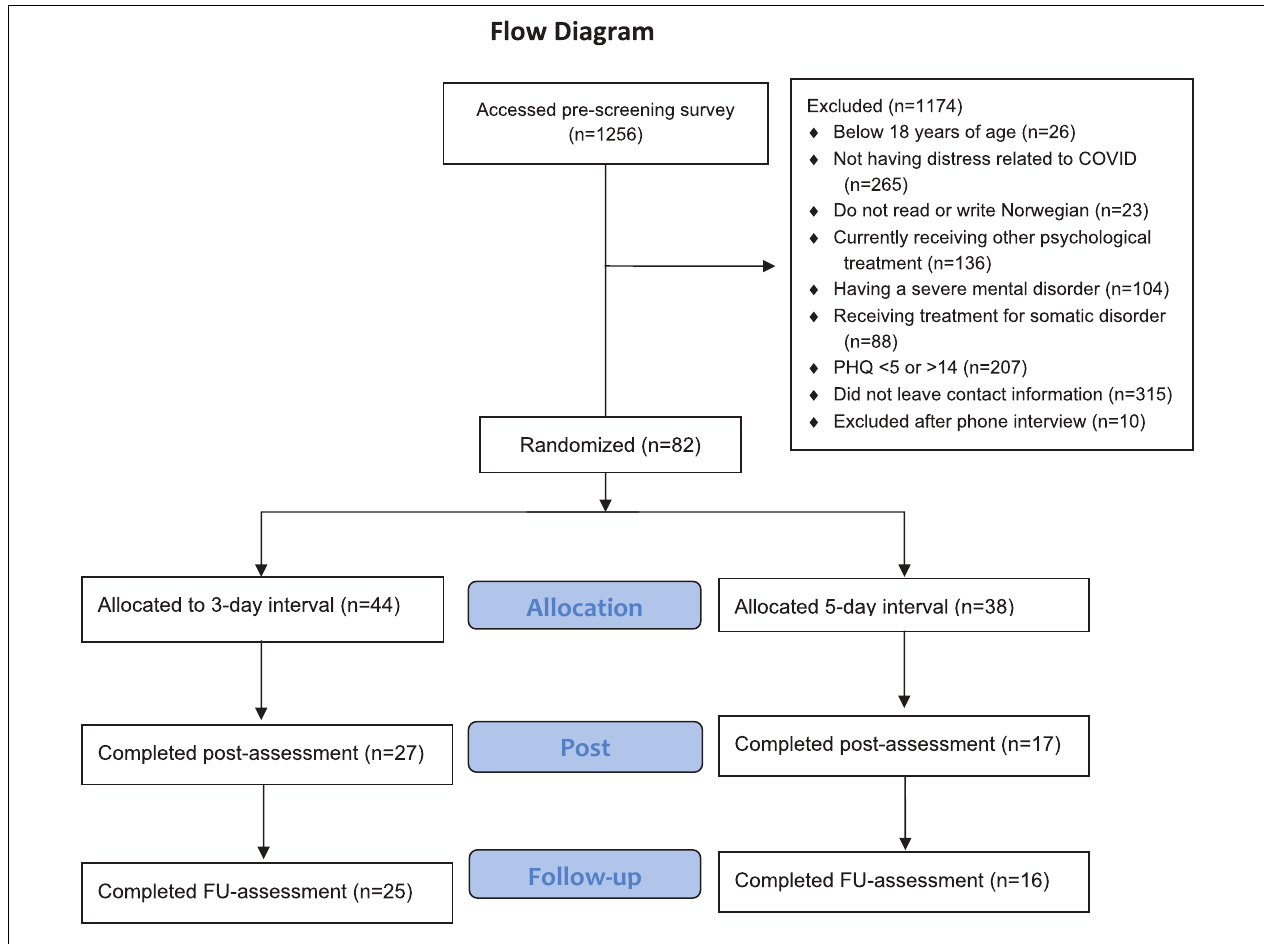
FIGURE 2 | Flow Chart.